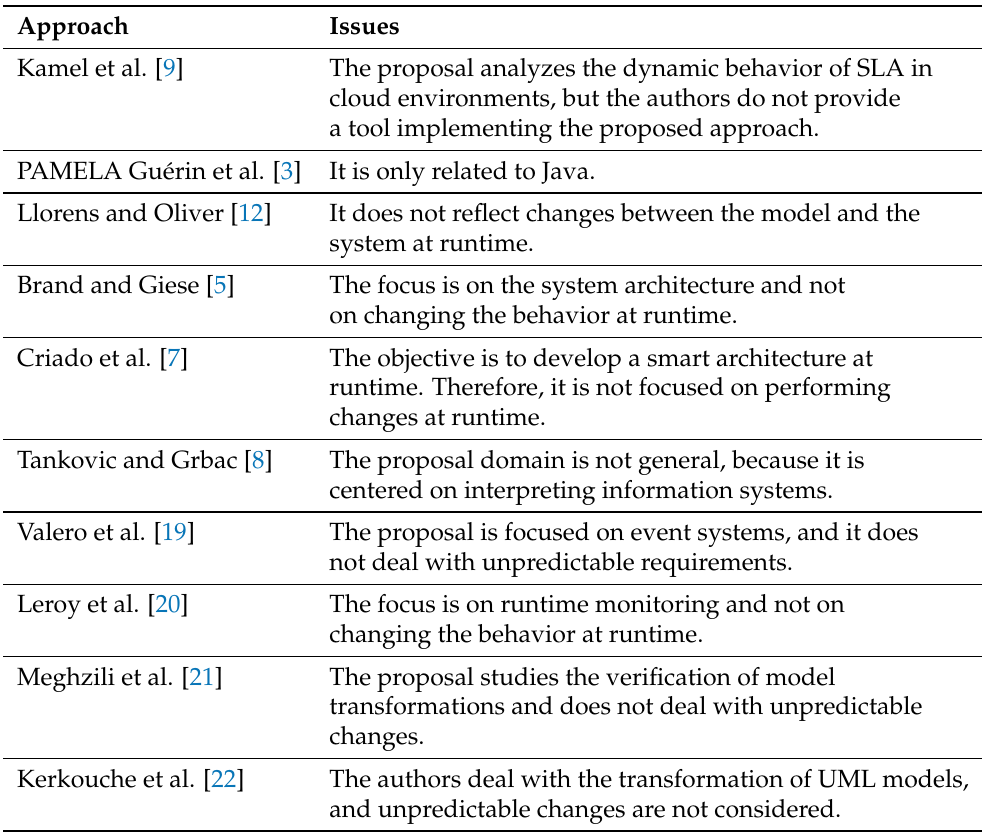
Table 1. Open challenges in previous works.